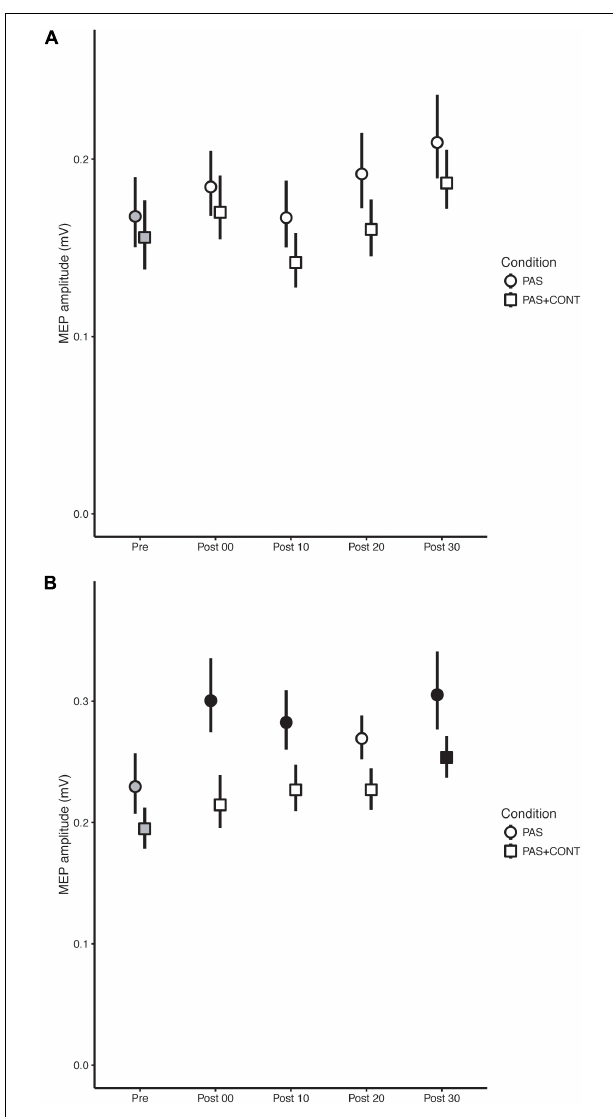
FIGURE 3 | Older healthy participants. The mean ( n = 13) MEP amplitude values obtained for the flexor carpi radialis (FCR) muscle (A) and extensor carpi radialis (ECR) muscle (B) at each time of measurement (Pre, Post00, Post10, Post20, Post30), are shown for the respective experimental conditions: paired associative stimulation (PAS); PAS plus contraction (PAS + CONT). The error bars are the 95% “Cousineau-Morey” confidence intervals. The values recorded prior to the intervention are shown as filled gray symbols. Instances in which a post-intervention measurement differed reliably from the pre-intervention value are shown as filled black symbols.